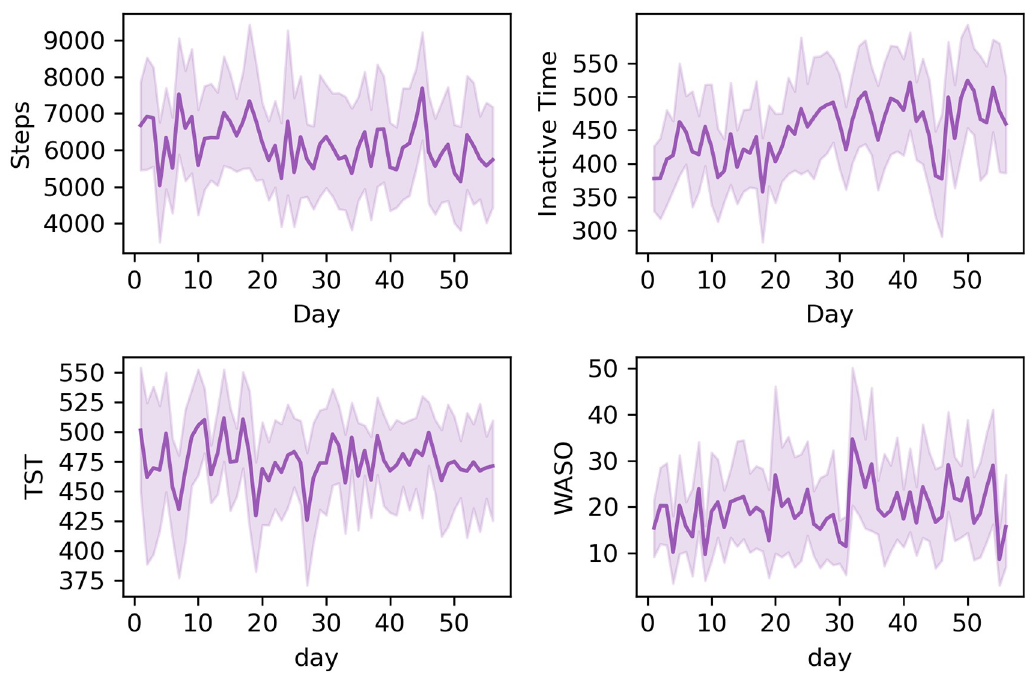
Fig 4. Trends in physical activity and sleep. The daily mean with 95% confidence intervals of daily steps, and daily inactive time (n = 28–37), and total sleep time (TST) and wake after sleep onset (WASO) (n = 22–32) during the eight-week data collection period (56